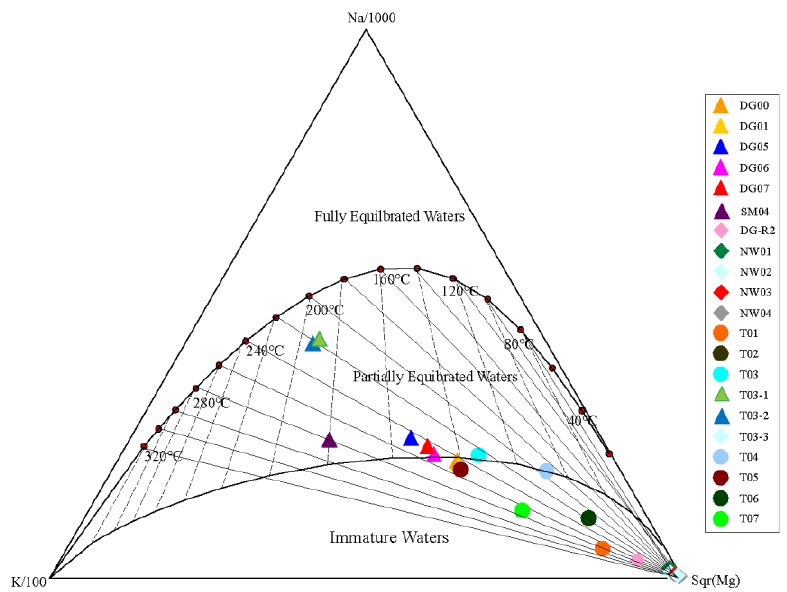
Figure 5. Na-K-Mg ternary diagram of samples along the TNR.